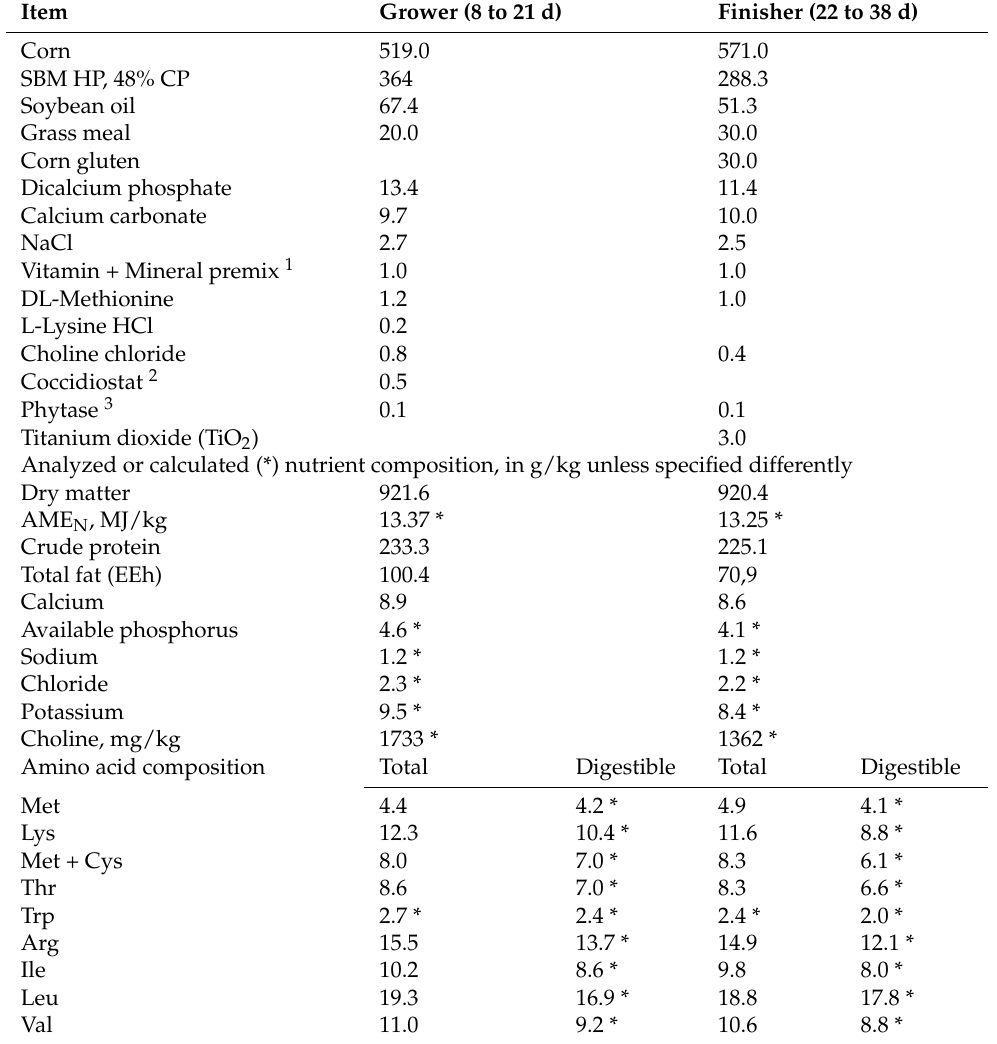
Table 1. Ingredients and nutrient composition of experimental broiler diets on an as-is basis.